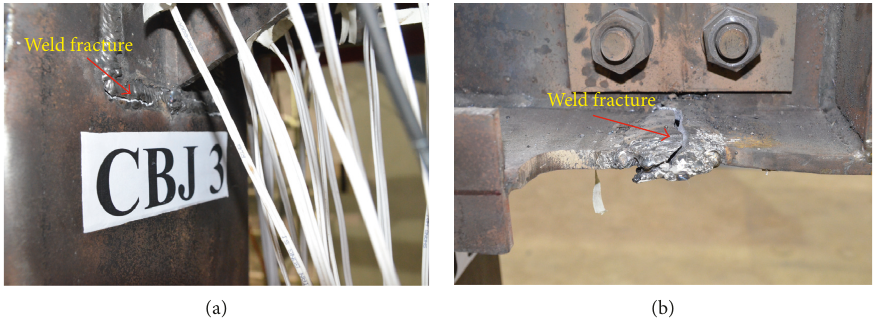
Figure 12: Failure modes of CBJ3: (a) the steel tube; (b) the right beam.